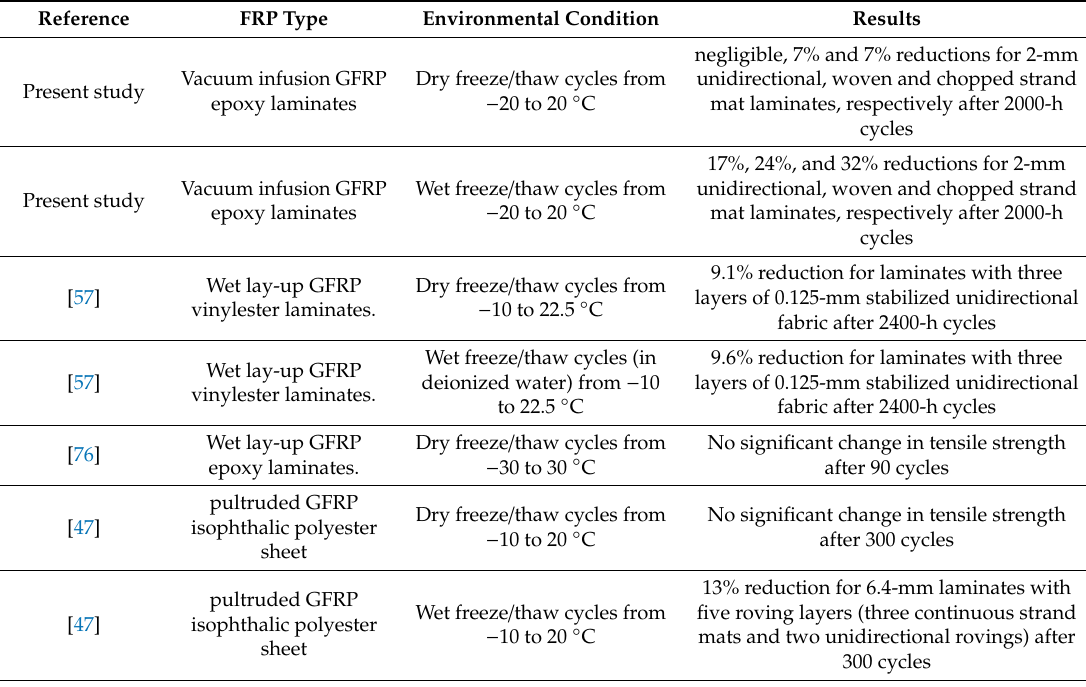
Table 3. Test results of the present study and other research under freeze / thaw cycles.